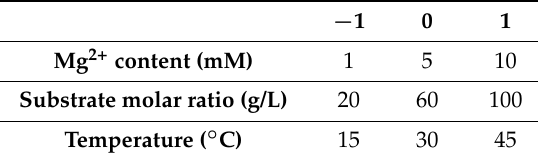
Table 2. Three-factor three-level table.